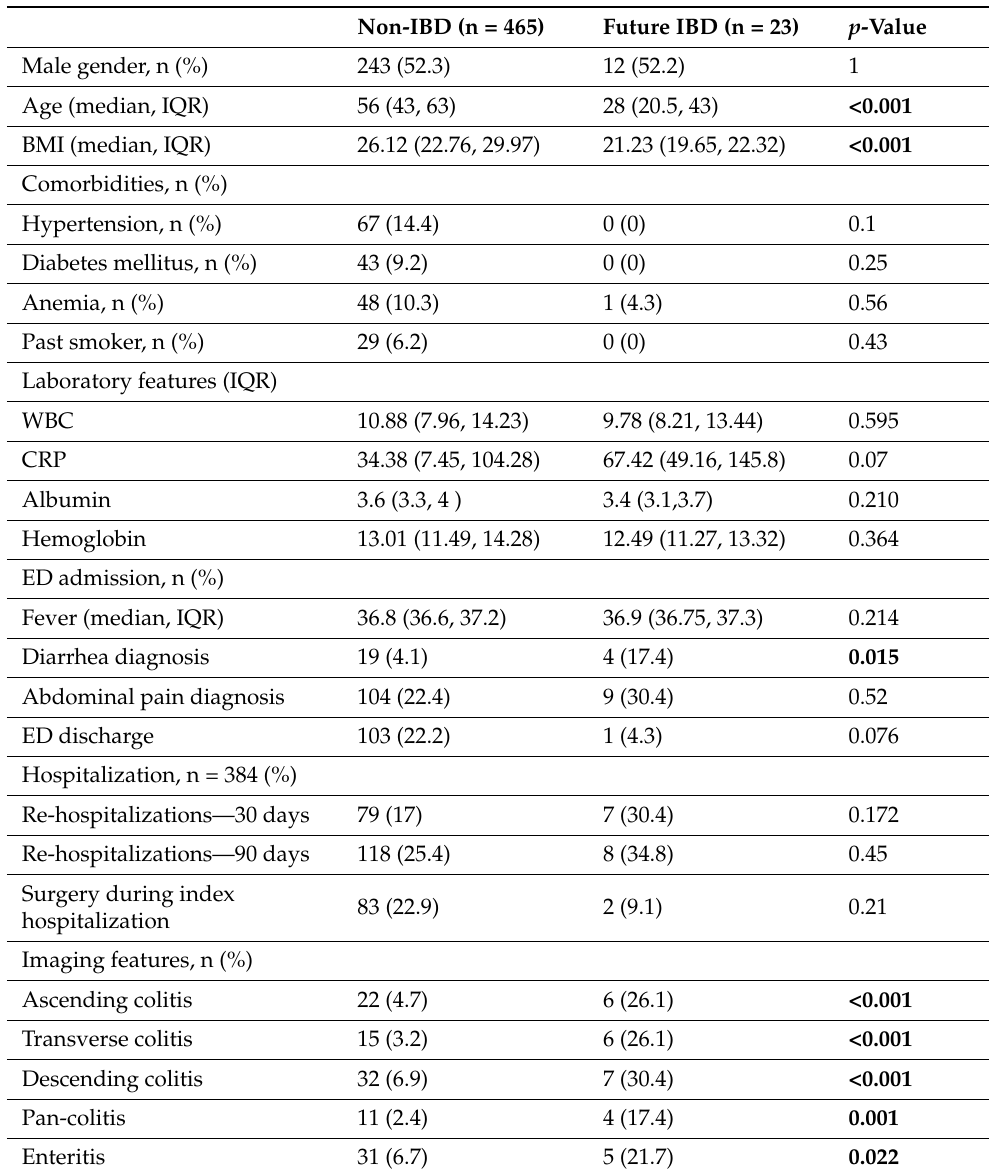
Table 1. Characteristics of study population—demographics, comorbidities, clinical and imaging features at ED